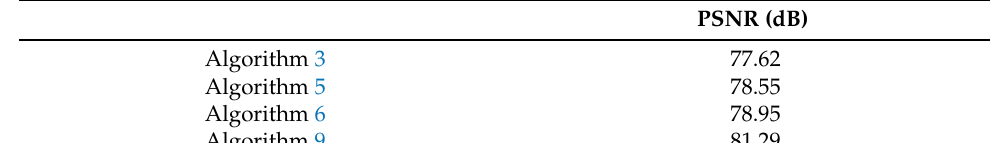
Table 5. PSNR of each algorithm at the 200th iteration.